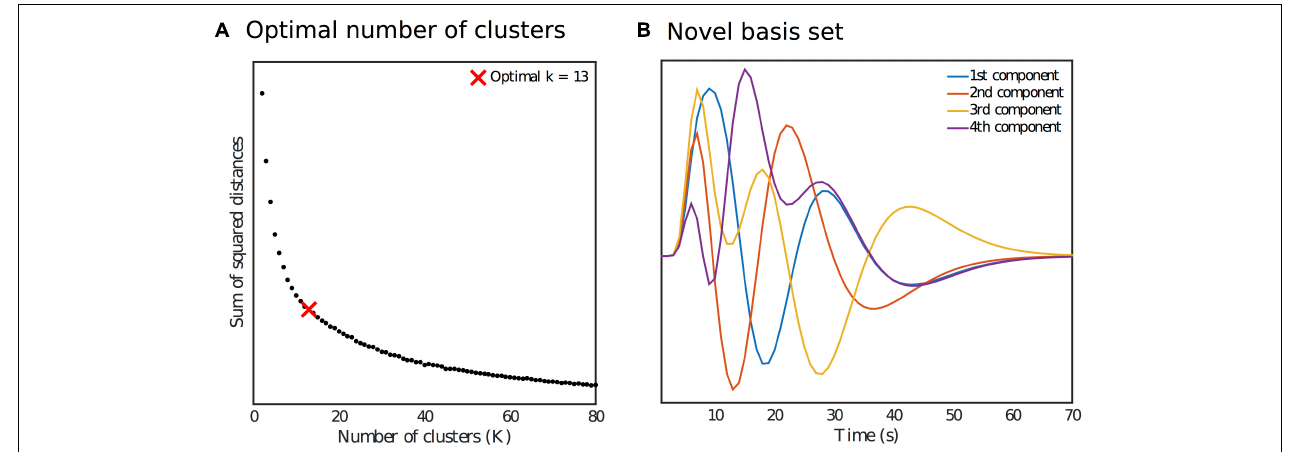
FIGURE 2 | (A) Identification of the optimal number of clusters k for the k-means reduction step as part of the generation of the novel basis set. (B) Orthonormal novel basis set.